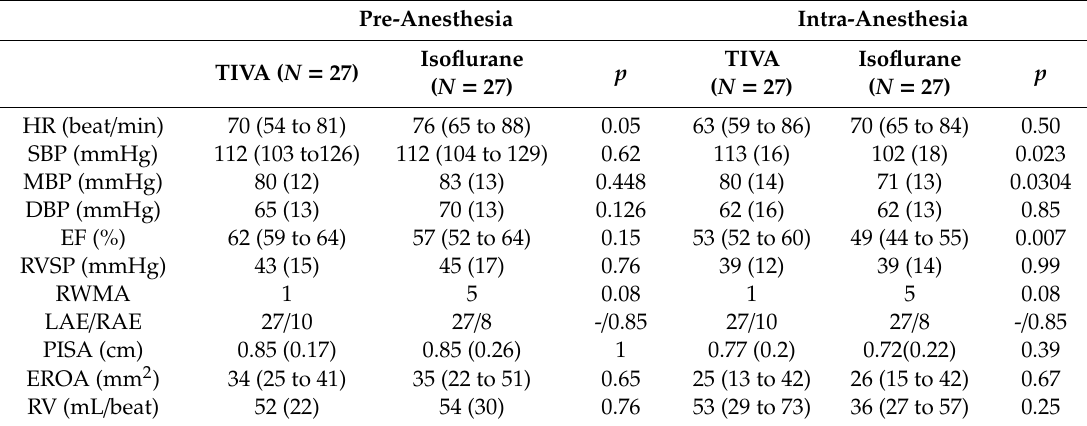
Table 2. Hemodynamics and mitral regurgitation